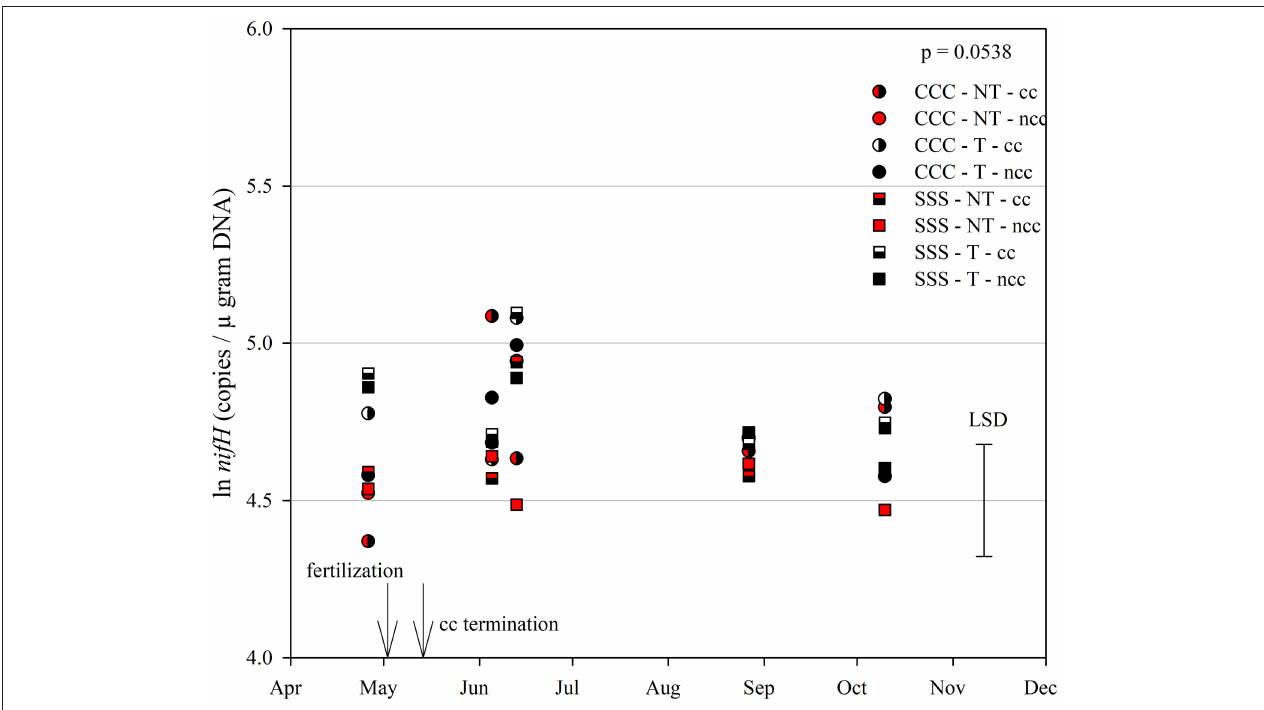
FIGURE 6 | Mean lognormal transformed soil nifH (copies µ gram DNA − 1 ) throughout the 2019 growing season separated by crop rotation [CCC, continuous corn (circles); SSS, continuous soybean (squares)], tillage [NT, no-till (red); T, chisel tillage (black)], and cover crop [CC, cover crop (partial fill); NCC, no cover crop (solid fill)]. Significant differences in treatment means can be interpreted by the Least Square Differences (LSD) error bar to the right of the figure. Mean values that fall beyond the distance of the LSD are significant at α = 0.10.